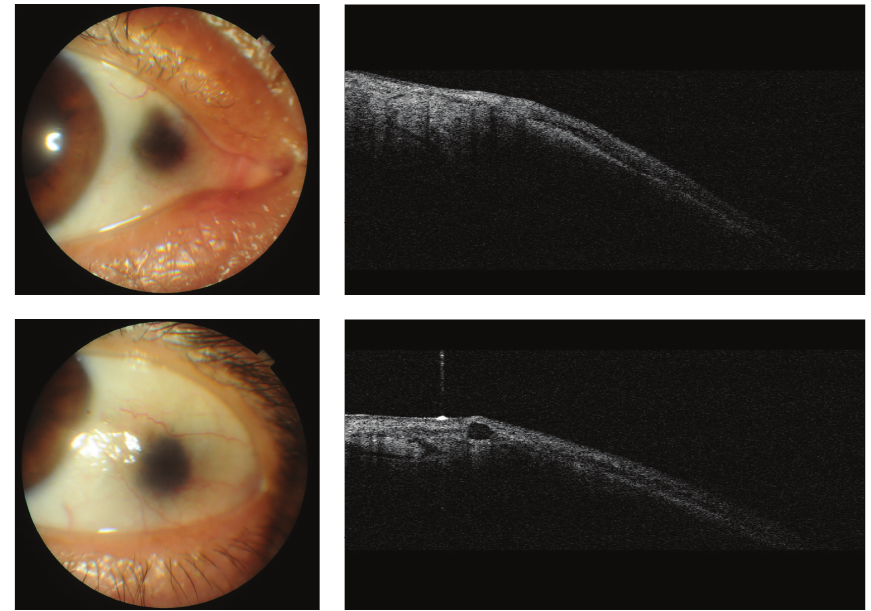
Figure 2: Anterior segment OCT of Case 1. Multiple hyporeflective areas with depth of 60 to 100 microns and width of 400 to 600